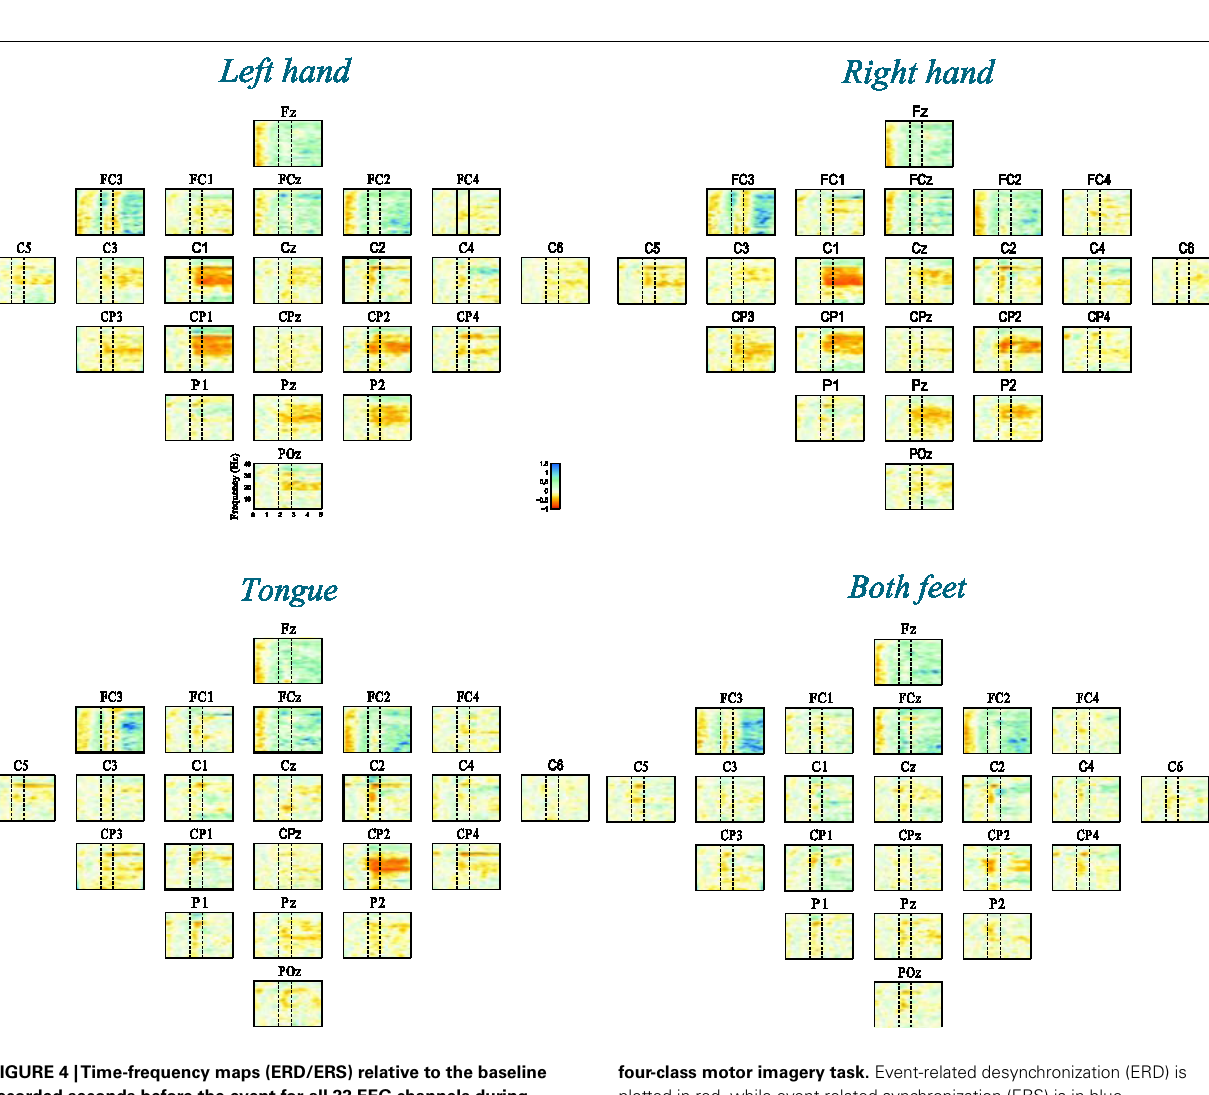
four-class motor imagery task. Event-related desynchronization (ERD) is plotted in red, while event-related synchronization (ERS) is in